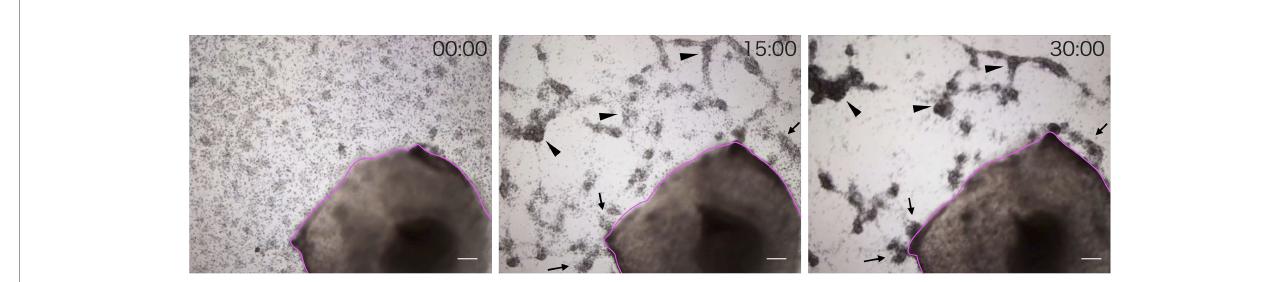
FIGURE 2 | Time-lapse observation of the movement of cells toward a piece of intestine. Images were acquired every 15 min. Magenta line: A piece of intestine. Arrow: Cells moved toward the growing aggregates. Arrowhead: Cells moved toward the piece of intestine. Scale bars =